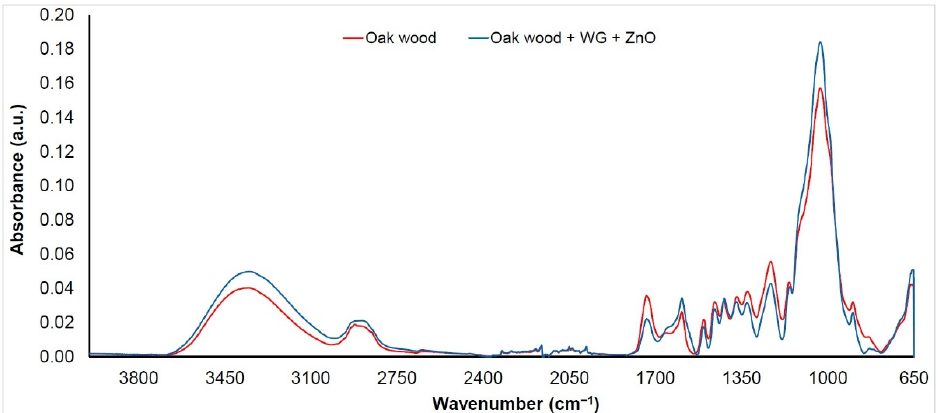
Figure 5. FTIR spectrum of oak wood coated with water glass and ZnO nanoparticles.